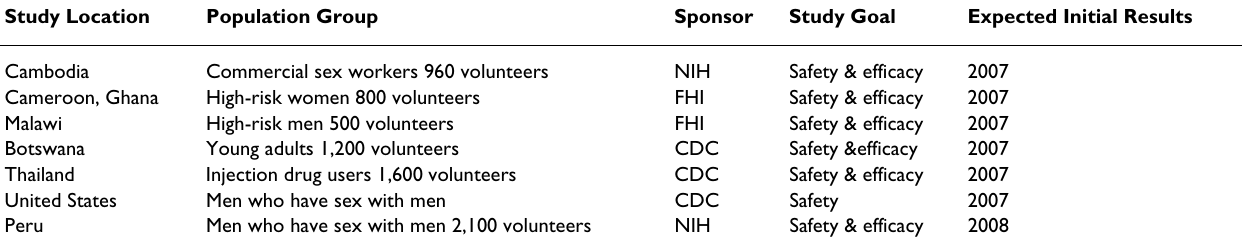
Table 1: Current tenofovir PREP Studies Study